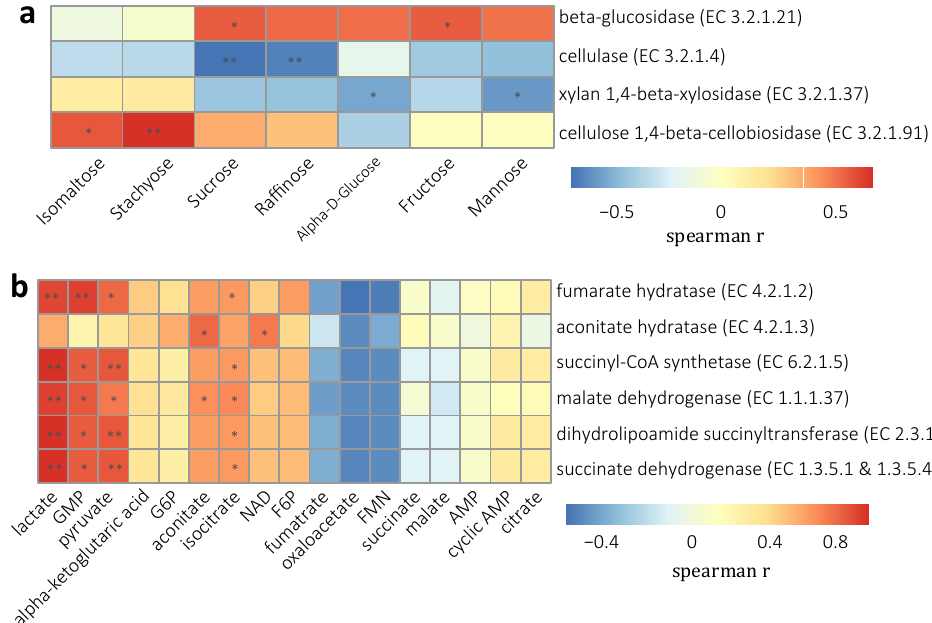
Figure 5. Heatmap of the correlation between functional genes of gut microbiota and fecal metabolites in giant pandas. ( a ) Correlation of carbohydrates-related metabolites with functional genes of gut microbiota. ( b ) Correlation of metabolites involved in energy-related metabolic pathways with functional genes of gut microbiota. The red and blue squares represent positive and negative correlations between metabolites and gut microbiota, respectively. The * symbols represent p < 0.05, ** symbols represent p <